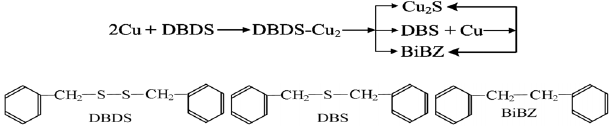
Figure 7. Chemical structure of dibenzyl disulfide (DBDS) and the reaction between DBDS and copper conductor.